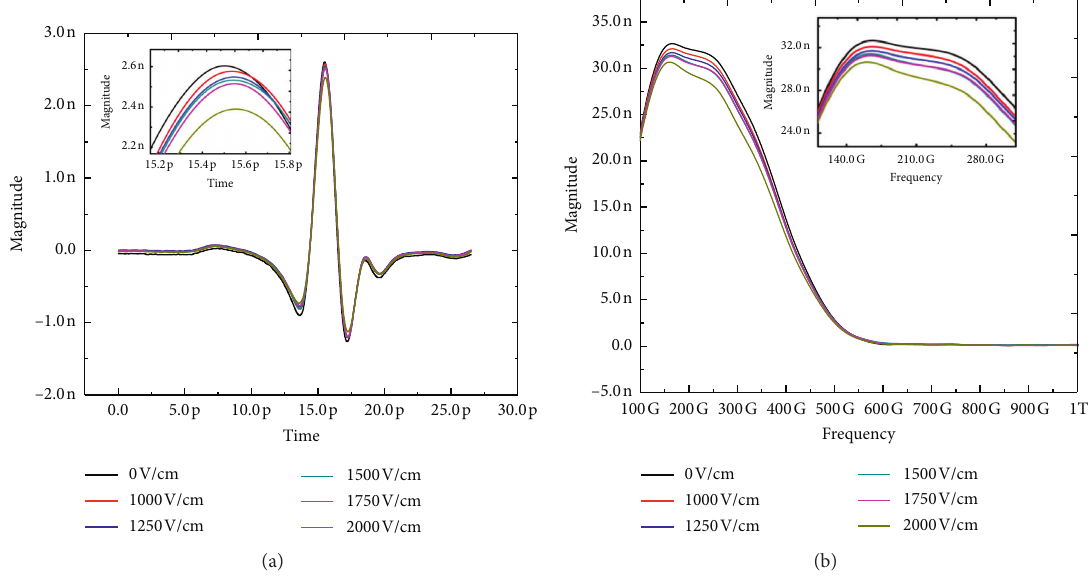
Figure 8: THz time domain spectrum (a) and frequency domain spectrum (b) with an applied parallel electric field.